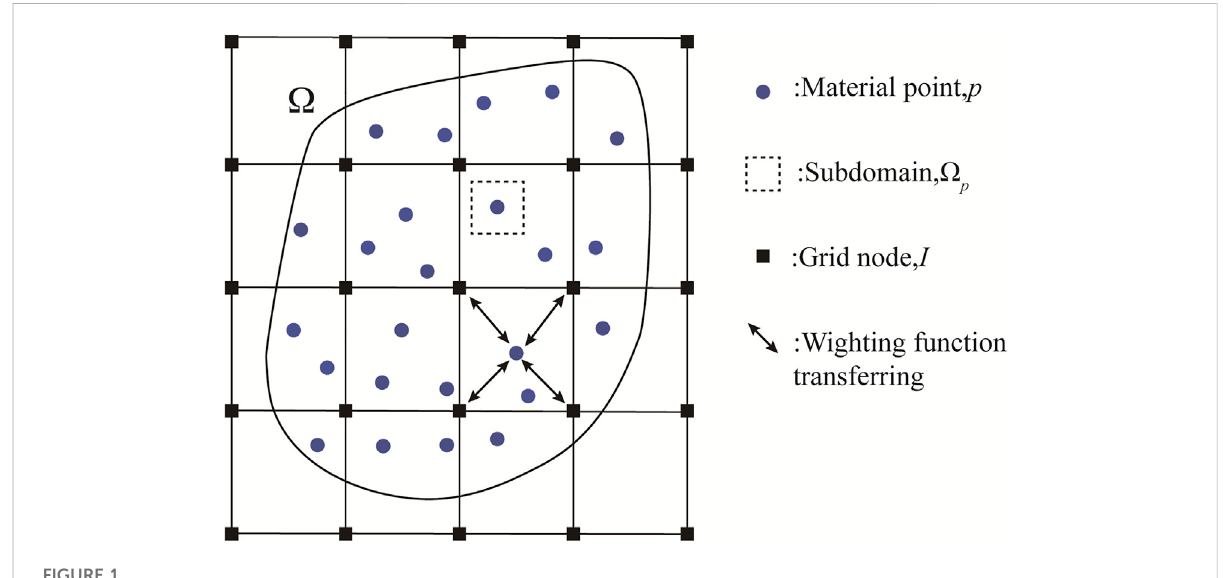
FIGURE 1 Discrete diagram of material point